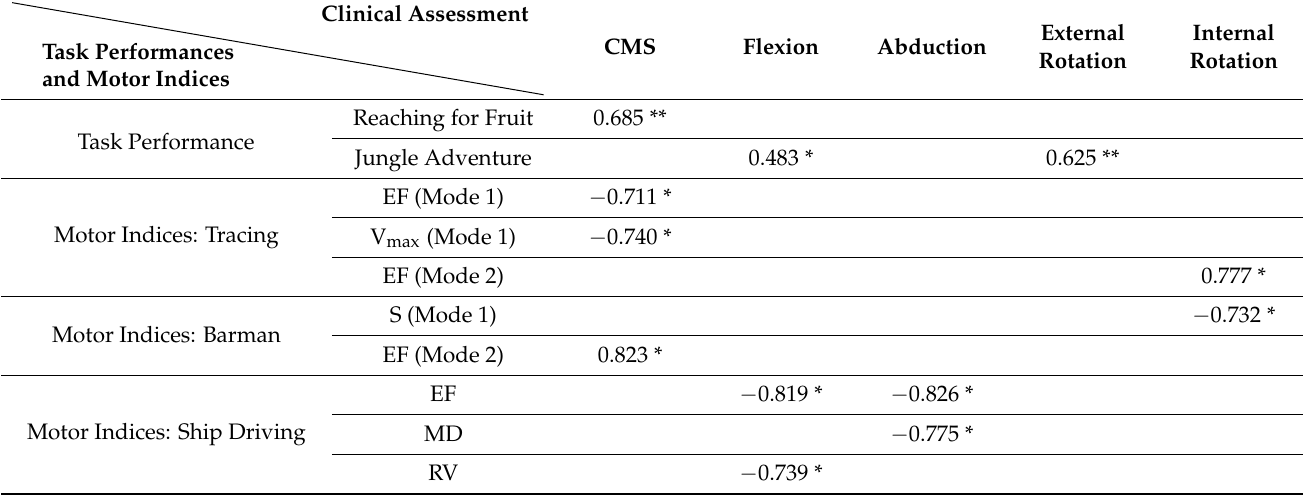
Table 11. The correlations between the clinical assessments and the task performance and motor indices.